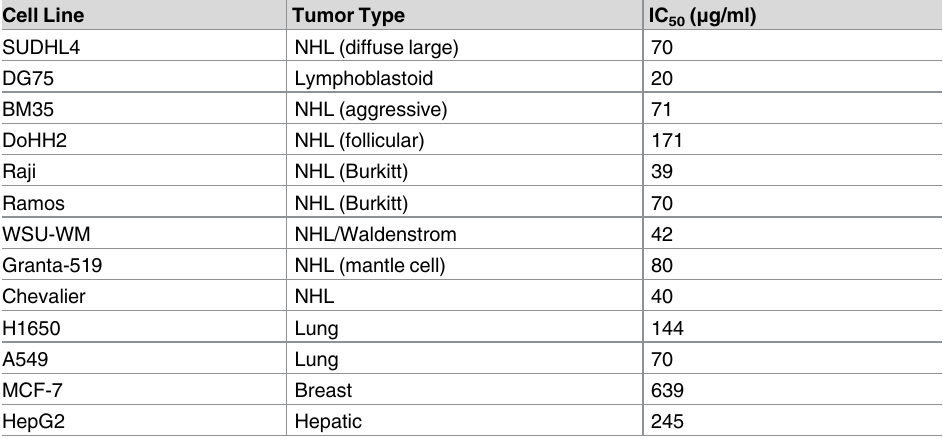
Table 1. Cytotoxic activity of FWGP. FWGP was assessed for cytotoxic potential in a panelof human can- cer cell lines. IC 50 s were calculatedfrom dose-response (growth